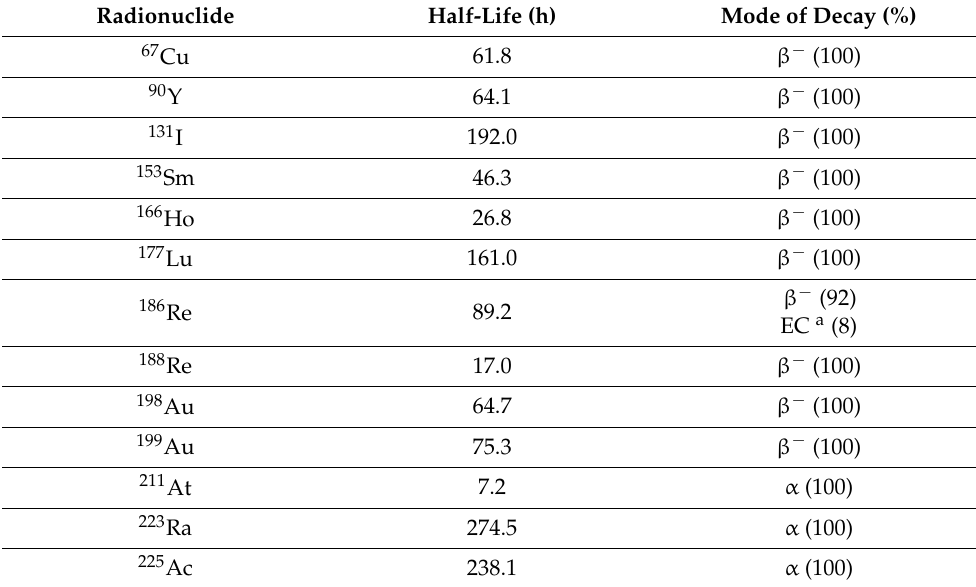
Table 2. Examples of Relevant Radionuclides for Therapeutic